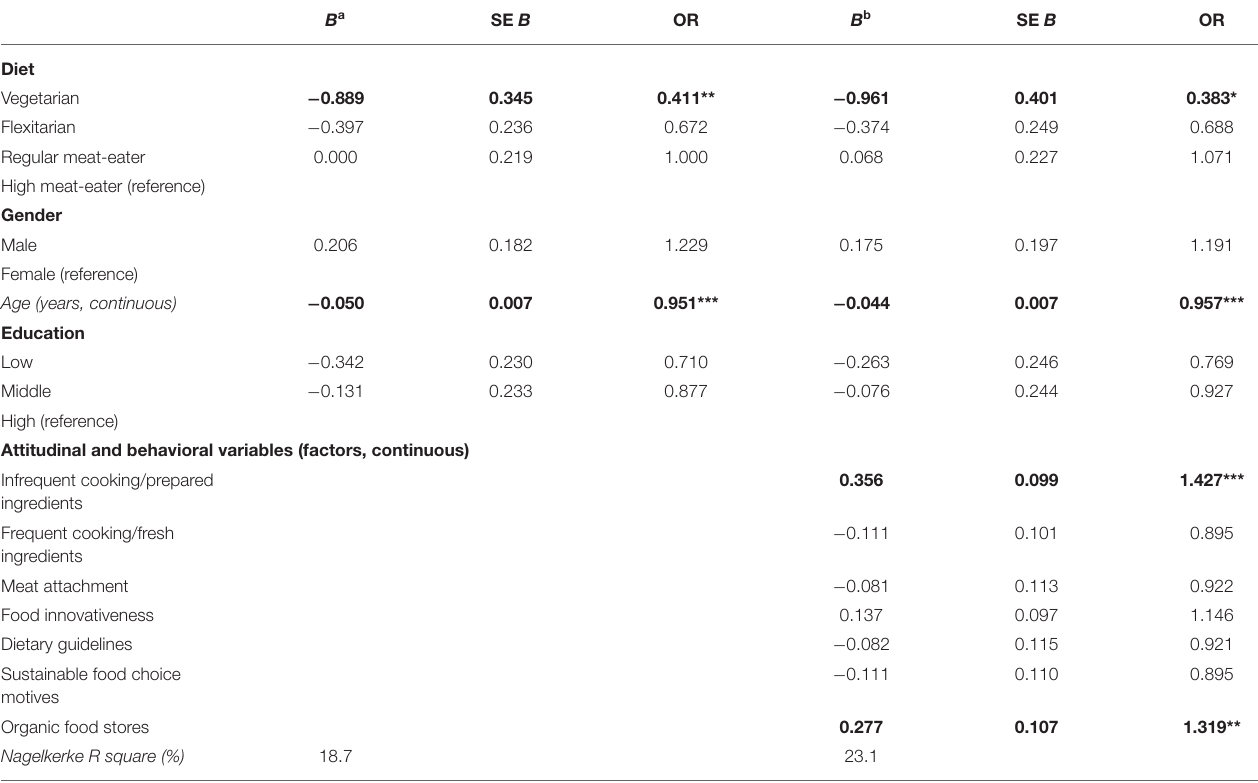
TABLE 8 | Results of a binary logistic regression analysis predicting fast food consumption ( N =